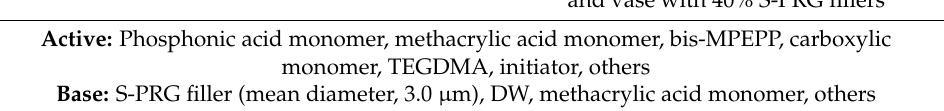
Table 1. Cont. Lot Composition Materials Group Number Same active ingredients as shown below 40% S-PRG ( w / w ) 40%-S 180130 and vase with 40% S-PRG fillers Active: Phosphonic acid monomer, methacrylic acid monomer, bis-MPEPP, carboxylic monomer, TEGDMA, initiator, others Base: S-PRG filler (mean diameter, 3.0 µ m), DW, methacrylic acid monomer,